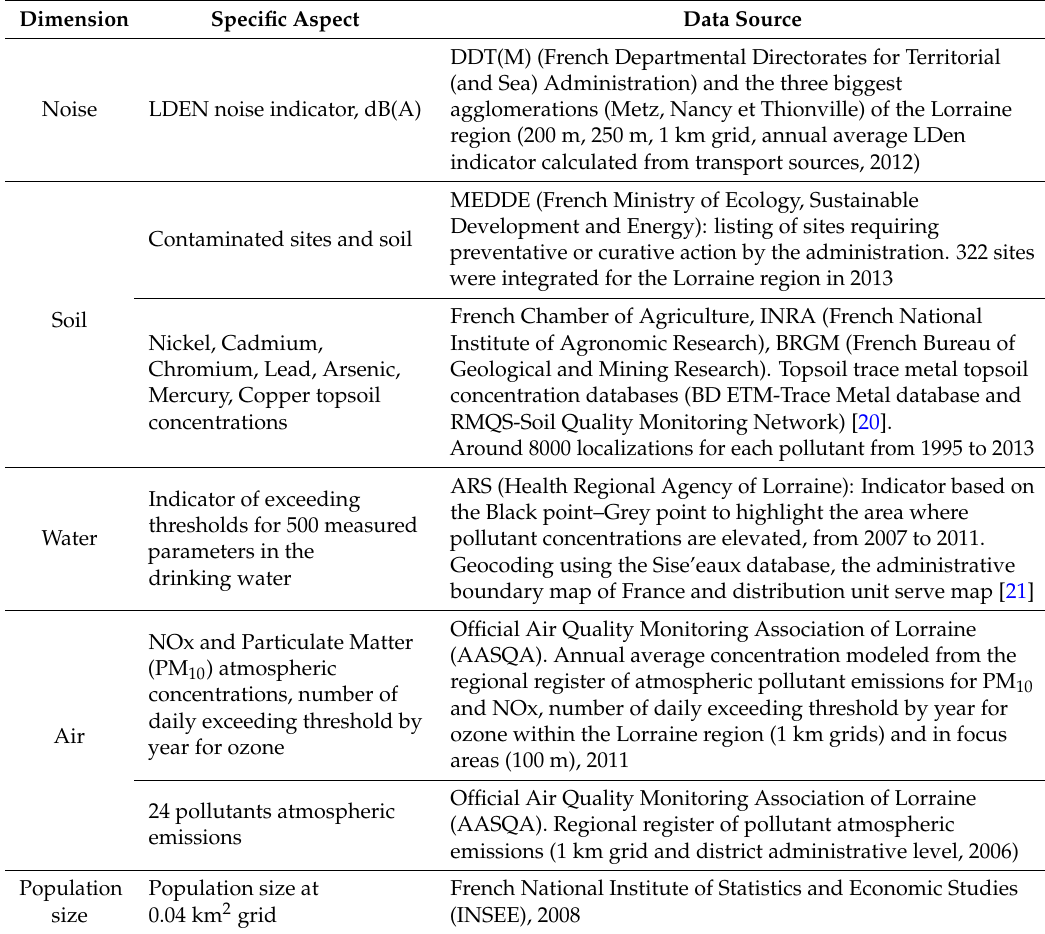
Table 1. Data sources included in the